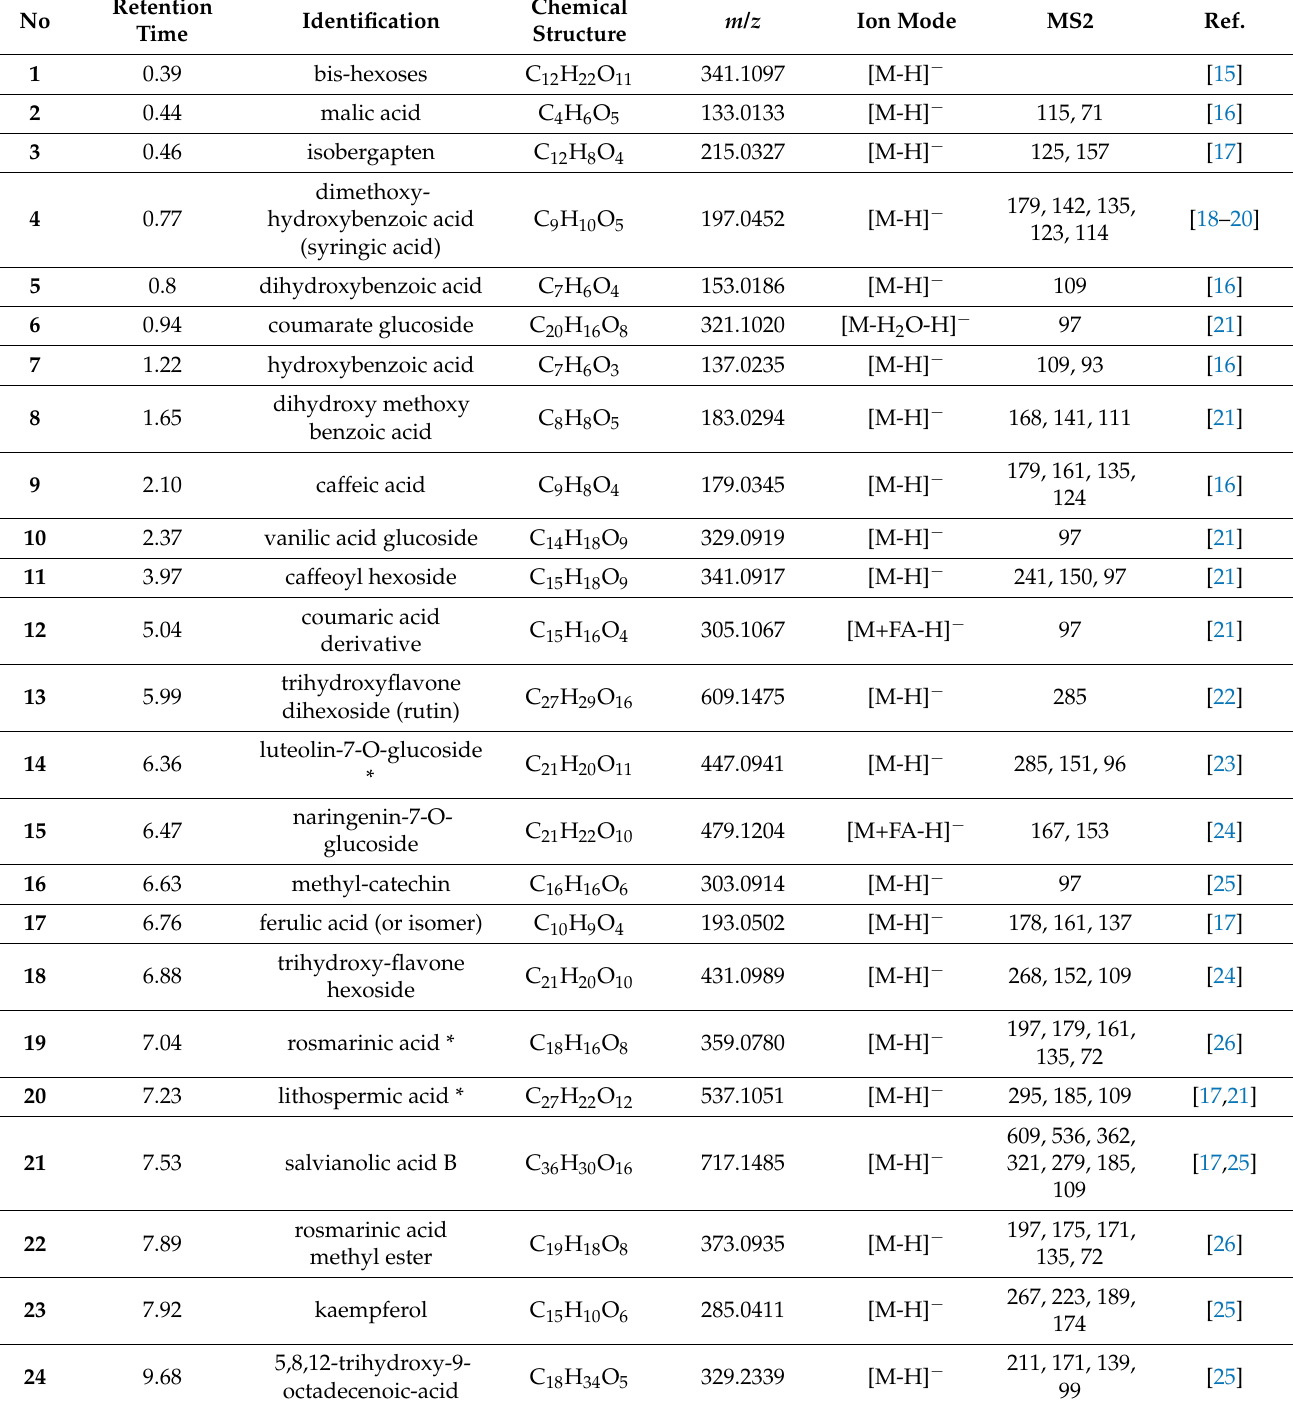
Table 1. Secondary metabolites identified from methanolic extract and fractions through